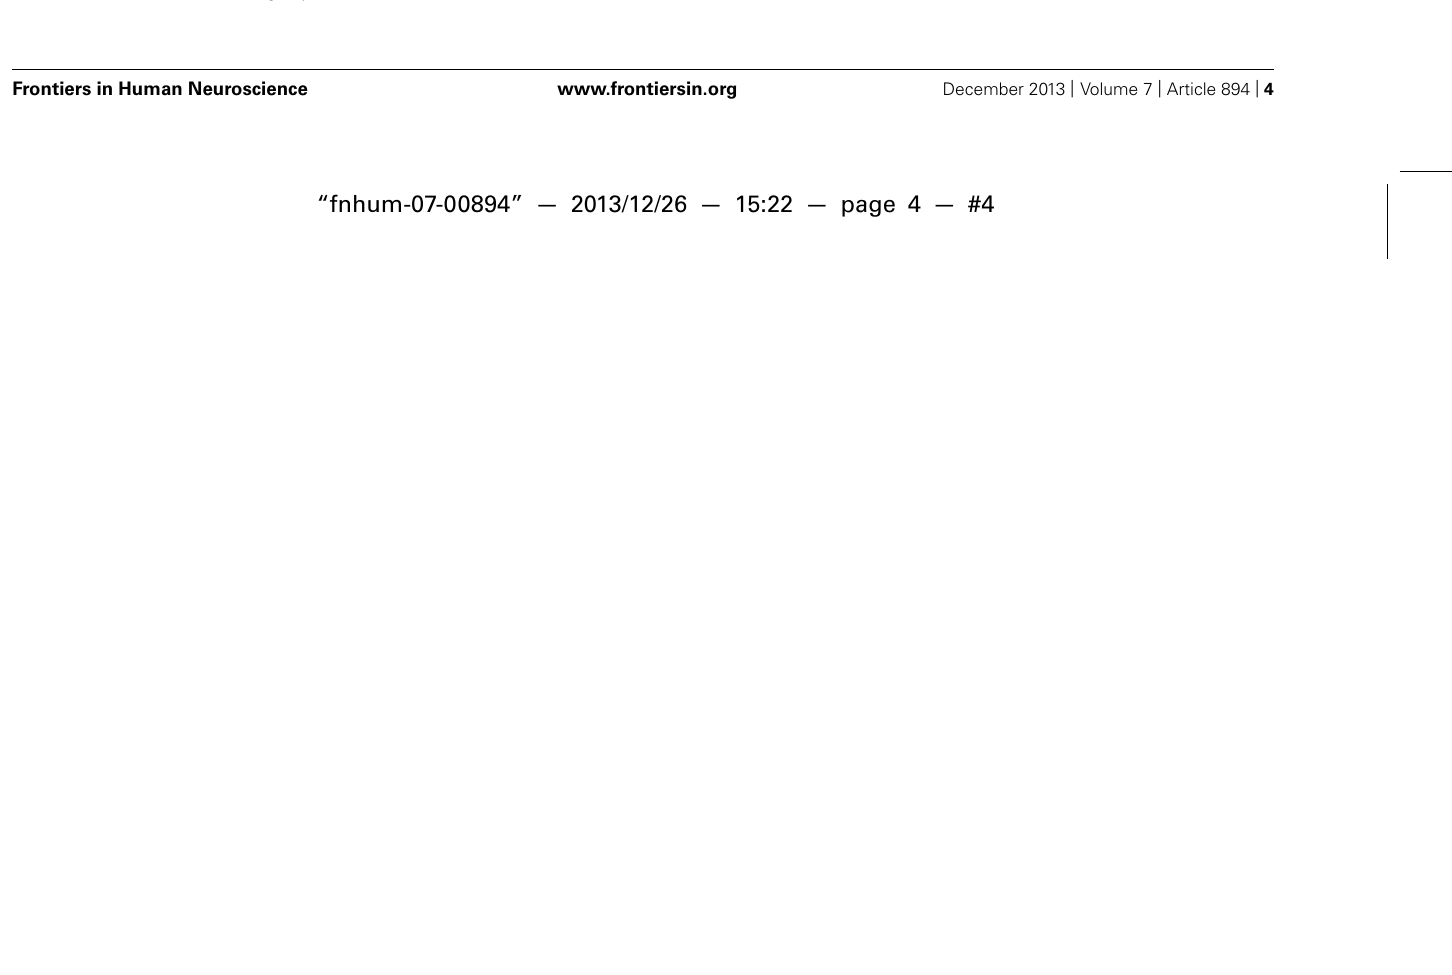
Results for meta-analytic contrasts comparing gray matter volume betweenTD and ASDs.When available, results are separately reported for Ch–Ado and Adu. Only results concerning the amygdala are reported. Ch–Ado, children–adolescents; Adu, adults; Amy, amygdala; R, right; L, left; < , decreased gray matter volume in ASDs; = , no difference between